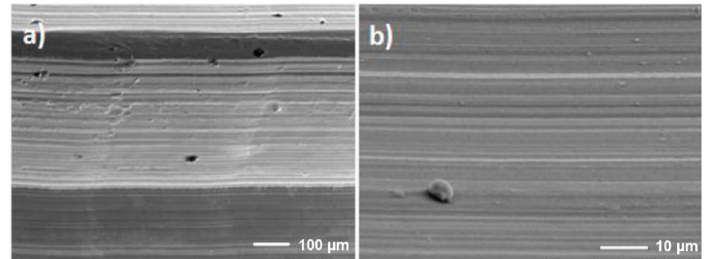
Figure 1. Surface of reference specimen at different magnification: ( a ) 130×, ( b )